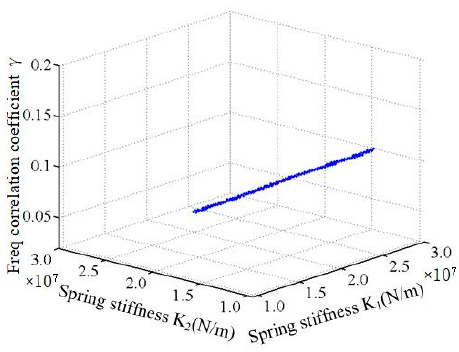
Figure 10. Composite curve of γ 1 and γ 5 .